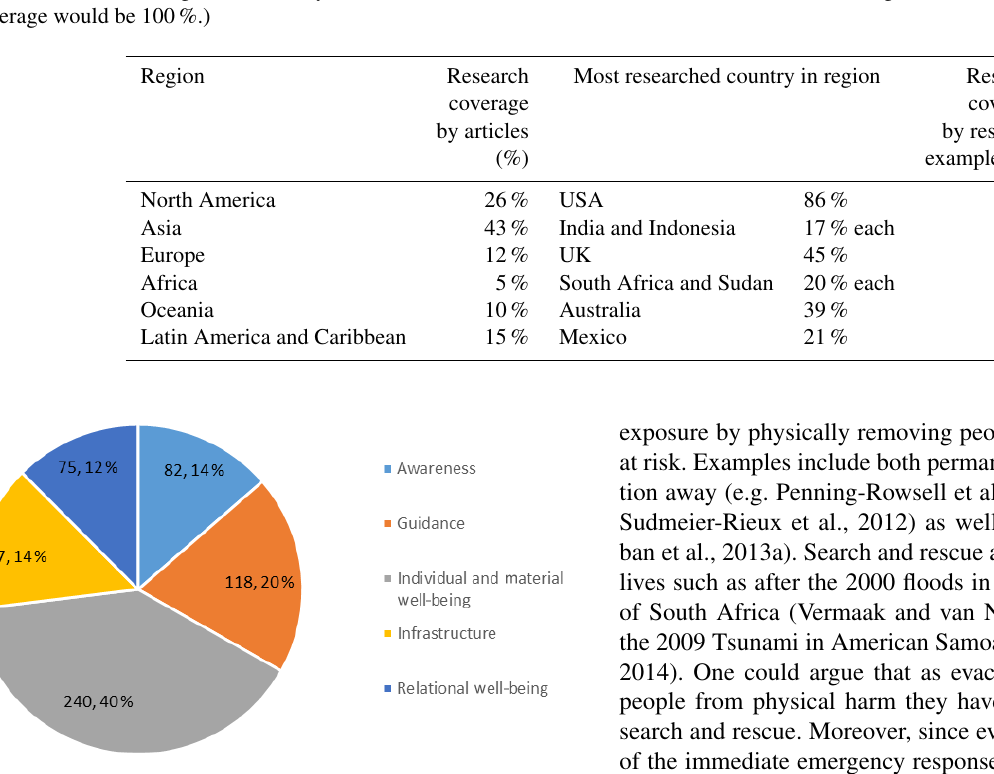
Figure 2. Frequency of use of response classes by communities; N = 602 communities utilize more than one type of